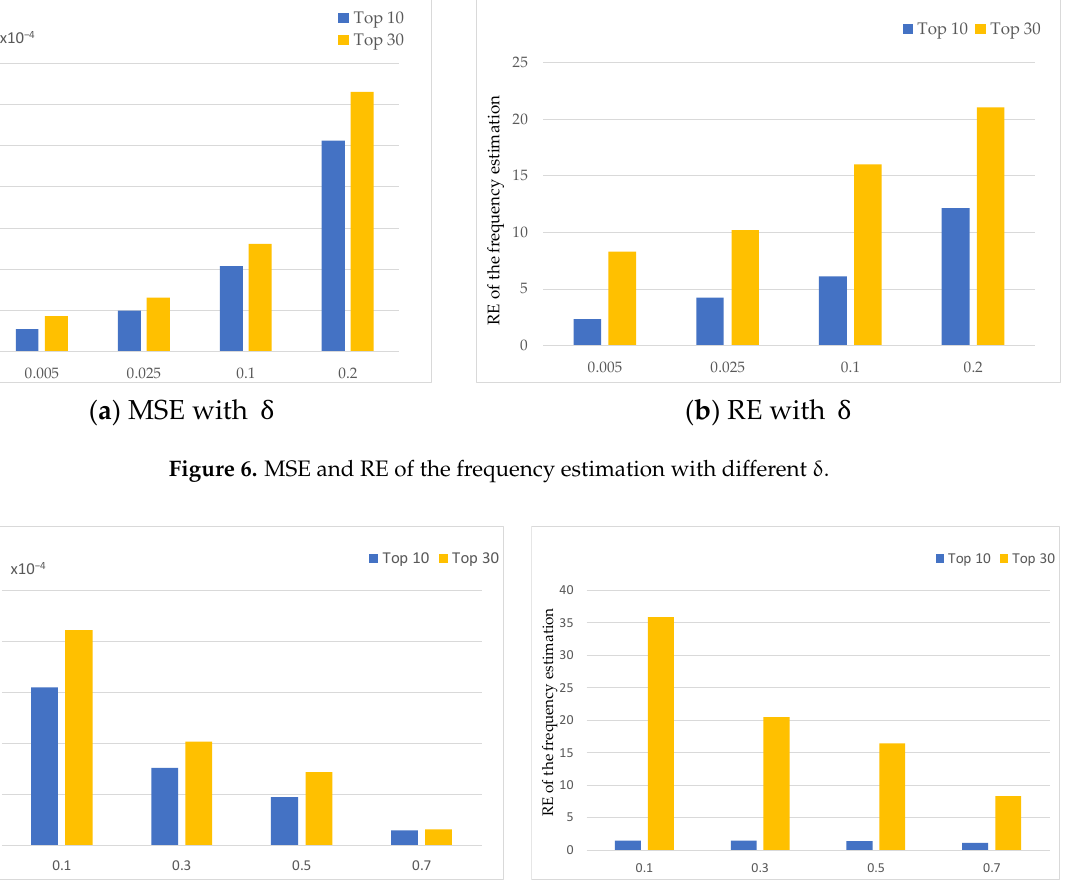
Figure 7. MSE and RE of the frequency estimation with different ϵ .